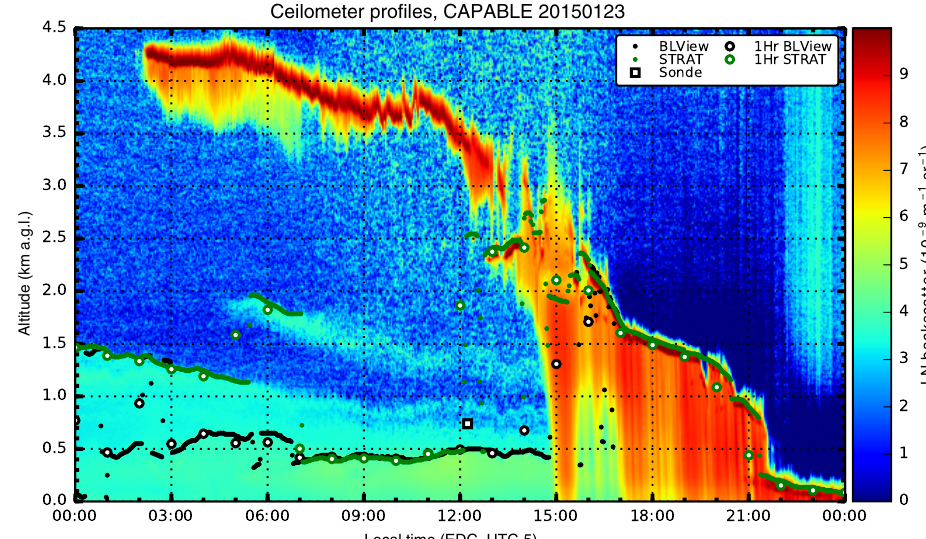
Figure 10. Example plot in which STRAT identifies cloud deck as the MLH